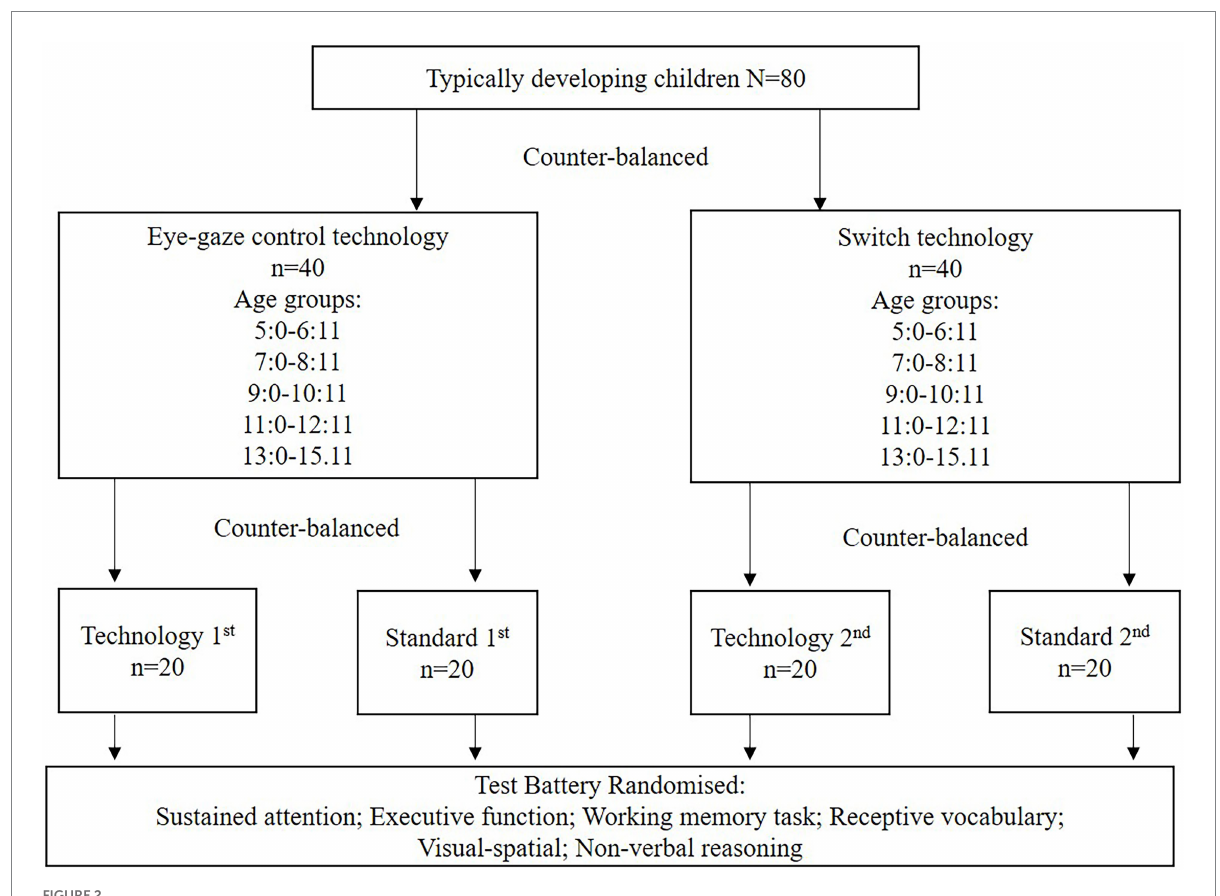
FIGURE 2 Counter balance design for typically developing